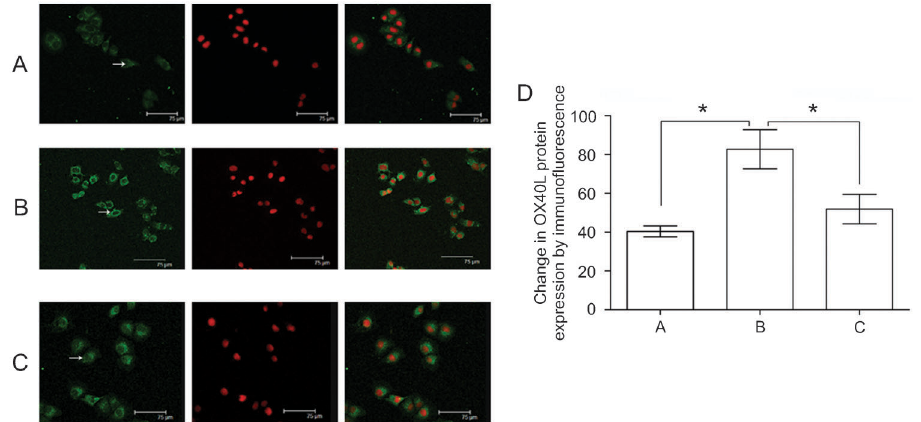
Figure 5. Change in OX40L expression with A , no Ox-LDL; B , 100 m g/mL Ox-LDL; C , 250 m g/ m L Poly I plus 100 m g/mL Ox-LDL. The cells were observed by laser confocal microscope (bar=75 m m). Green fluorescence indicates OX40L protein. Red fluorescence indicates nucleolus. Red and green fluorescence show the location and volume of OX40L protein. D , Average fluorescence value of 8 randomly selected cells. OX40L was expressed on HUVEC membranes. OX40L protein expression in group B was increased compared to group A, while the expression of OX40L in group C was decreased compared to group B (n=4; *P , 0.05, t -test). HUVECs: human umbilical vein endothelial cells; Ox-LDL: oxidative low-density lipoprotein; Poly I: polyinosinic acid.